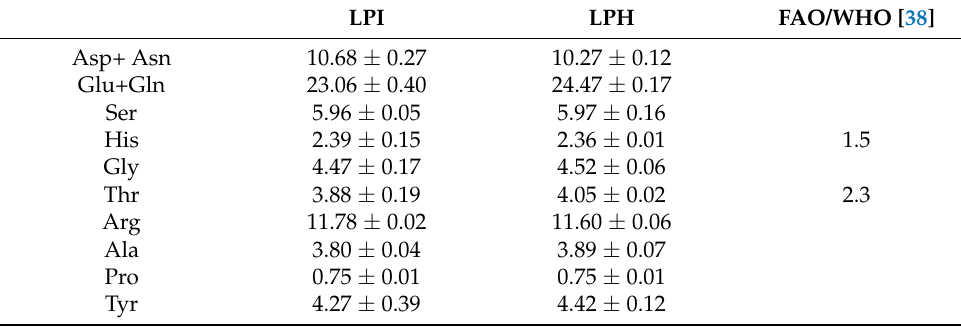
Table 2. Amino acid composition of LPI and LPH. Data, expressed as percentage of amino acids on total amino acid content, are mean ± standard deviation of three